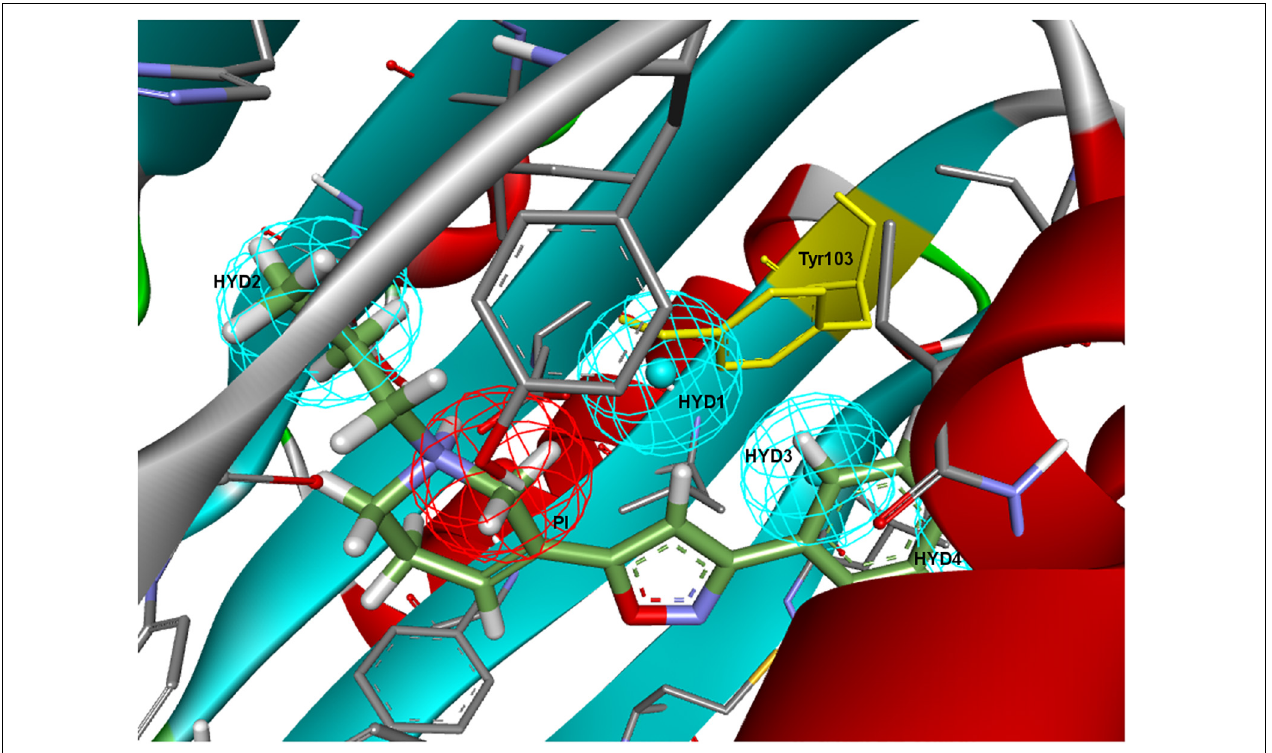
FIGURE 3 | Langer–Ph positioned in the active site of the σ 1R. Note that HYD1 collapses with Tyr103 (in